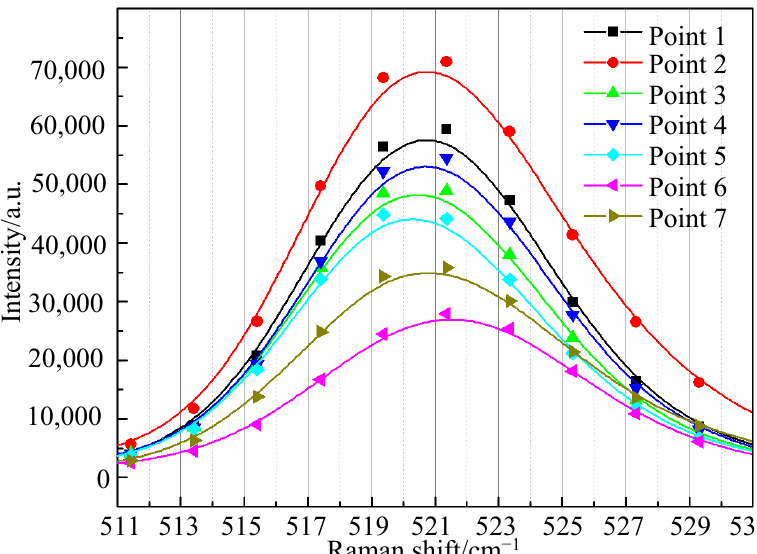
Figure 8. The fitted Raman curve for the Raman peak. Three kinds of silicon wafers are measured by this above method. The Raman peak and Raman shift of seven measurement points on one as-sawn silicon wafer are shown in Figure 9. Thirteen points are measured on each wafer shown in Figure 4. The residual stress and Raman shift for these measurement points are shown in Figures 9 and 10. It can be seen that the residual stress on these three kinds of wafers distribute unevenly. The tensile stress and compressive stress exist simultaneously.